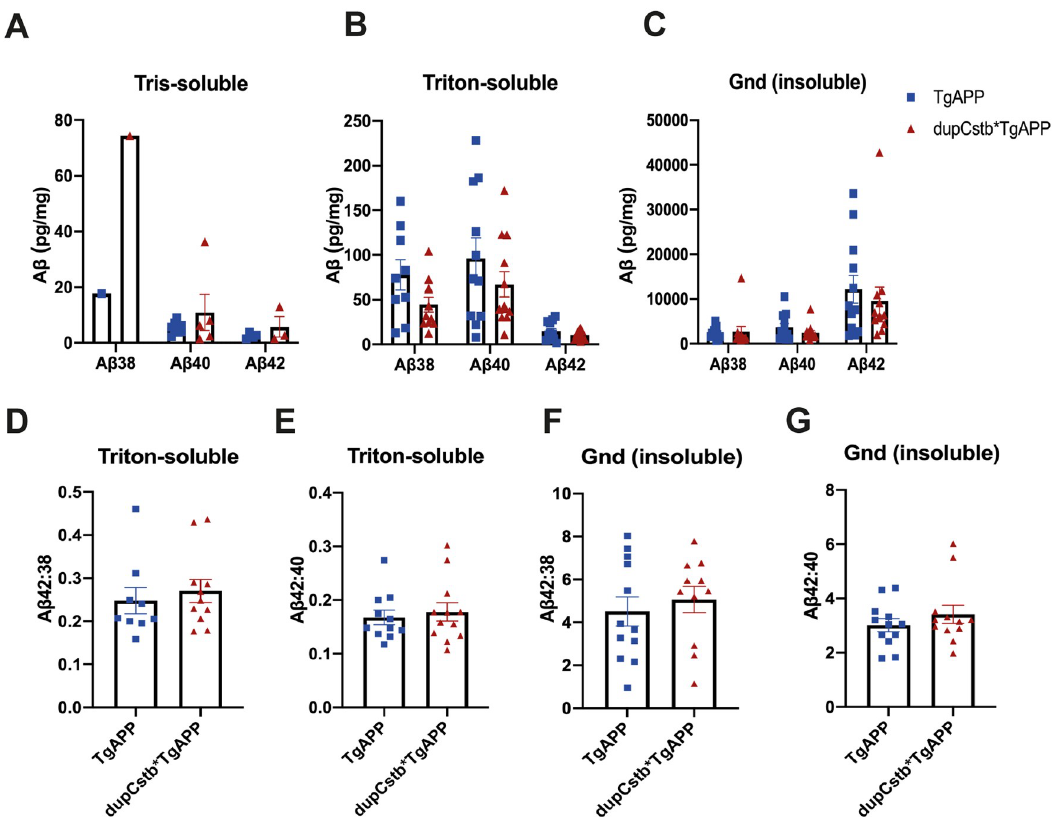
Fig 3. Cortical A β 38, A β 40, and A β 42 in 6-month old mice, as measured by Meso Scale Discovery Assay. (A-C) Representation of group means for the Tris-, Triton-, and Gnd-soluble fractions. Samples below detection limit were recorded as ‘0’ in the graph. Values are in pg per mg total protein, ± SEM (WT and dupCstb n = 5 all below limit of detection, tgAPP and dupCstb � tgAPP n = 12; 17 females and 17 males in total). (D-E) Ratio of A β 42:A β 38and A β 42:A β 40 was calculated in the Triton- soluble fractions. (F-G) Ratio of A β 42:A β 38 and A β 42:A β 40was calculated in the Gnd- soluble fractions. (A-G). No significant differences were found between tgAPP and dupCstb � tgAPP mice by univariate